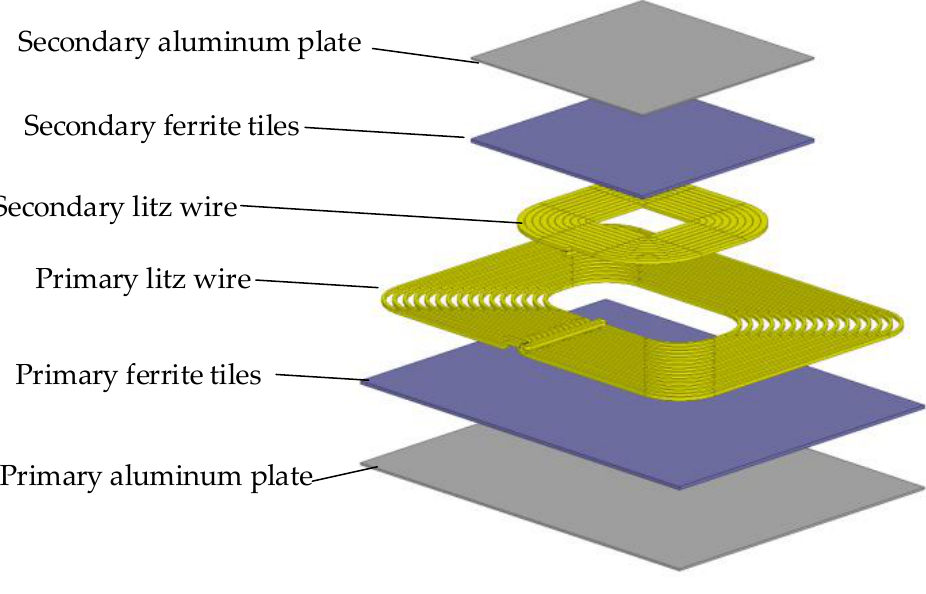
Figure 4. Magnetic coupler structure.